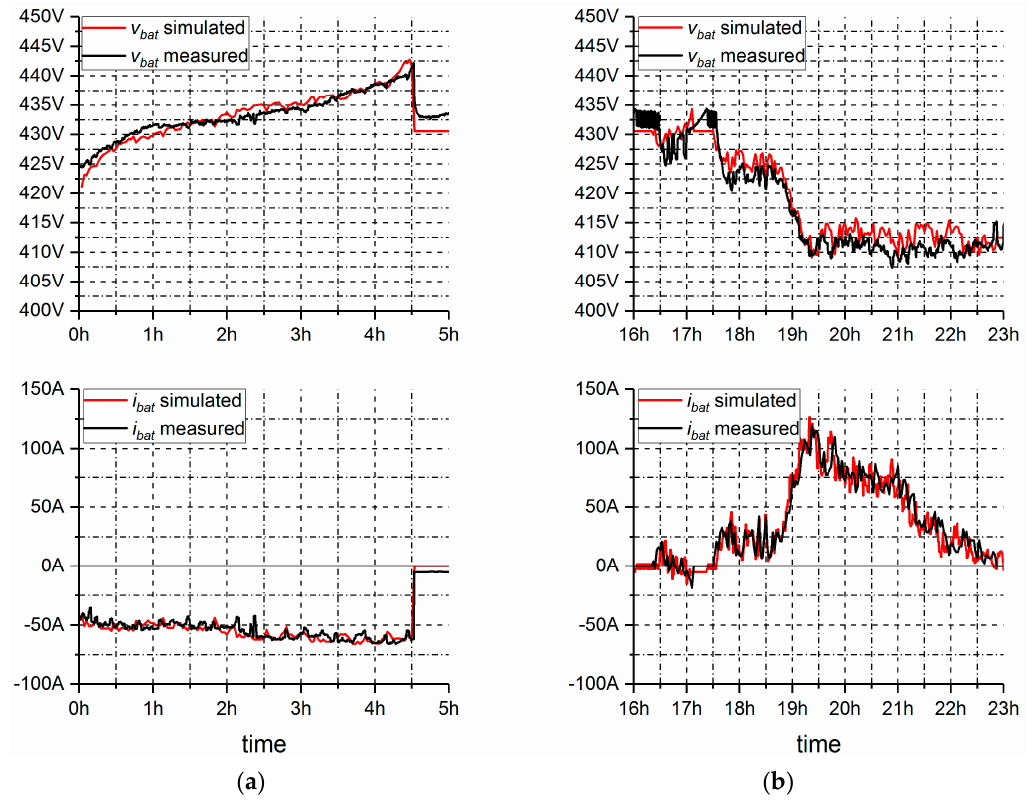
Figure 21. Simulation and measurement results for PSIM model ( a ) charging and ( b ) discharge.